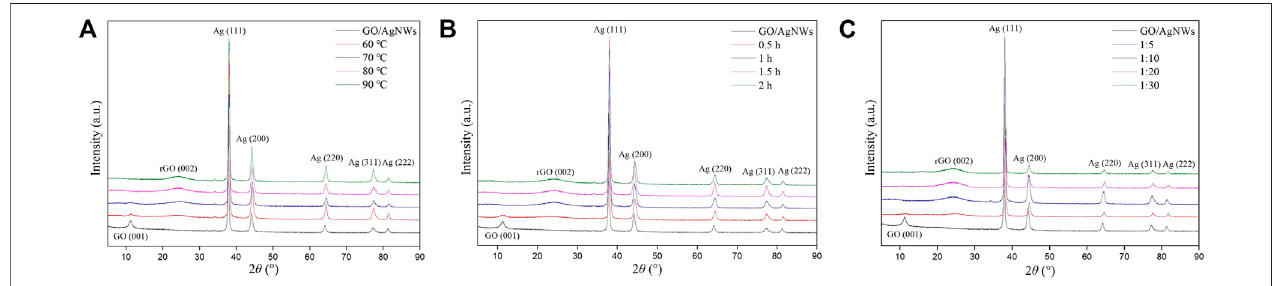
FIGURE 2 | XRD spectra of the reduced rGO/AgNWs paper at different reaction temperatures (A) , reaction time (B) , and the ratio of L-AA and GO (C)